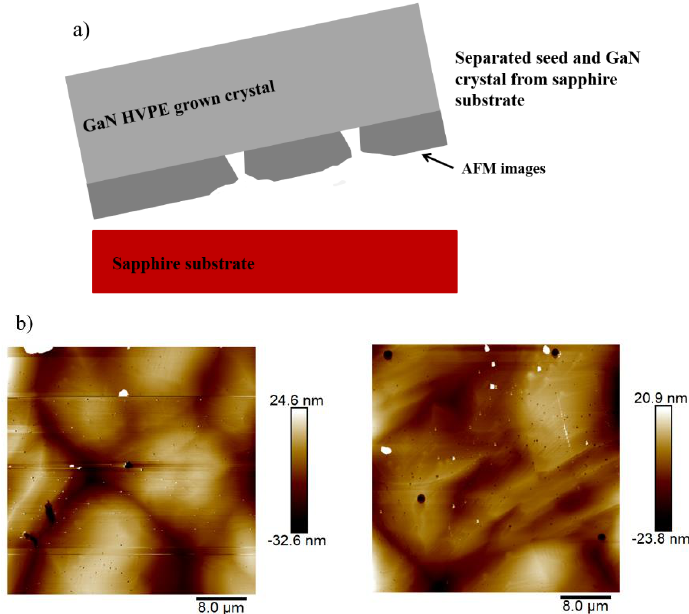
Figure 8. A schematic presenting the separated hydride vapor phase epitaxy (HVPE) GaN crystal with the in-situ etched MOVPE GaN seed layer ( a ) and atomic force microscopy (AFM) images from the separated interface of the in-situ etched GaN seed layer and crystal from sapphire substrate ( b ).